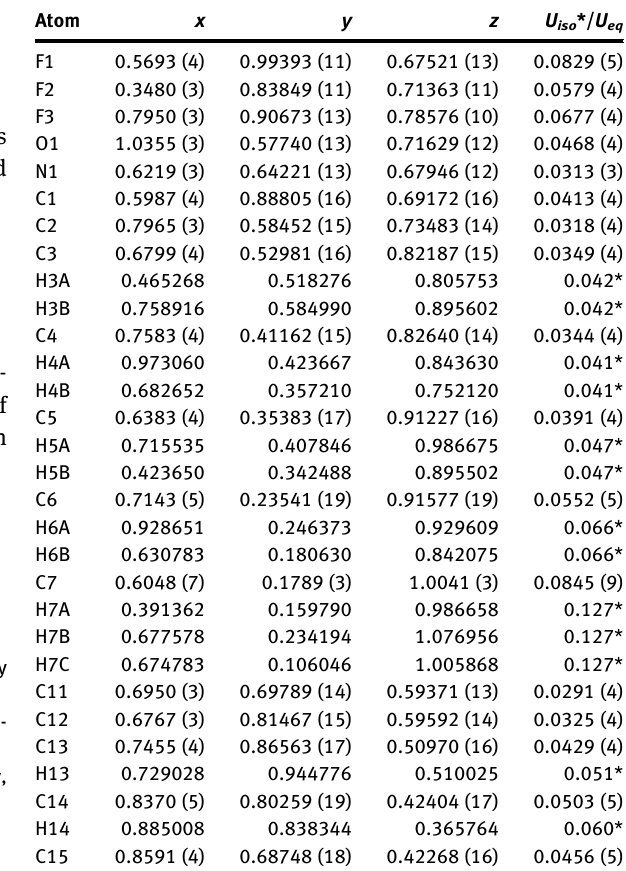
Table  : Fractional atomic coordinates and isotropic or equivalent isotropic displacement parameters (Å 